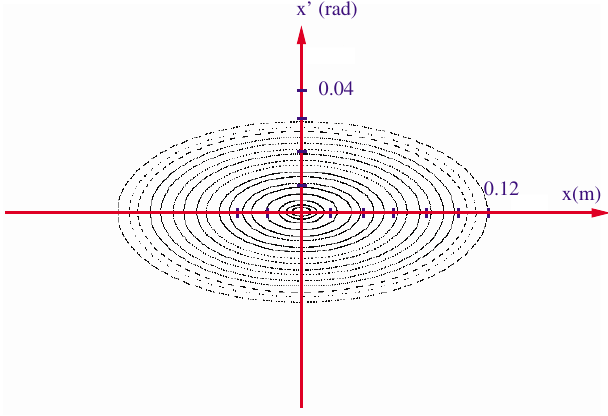
FIG. 18. (Color) Results from transverse particle tracking at the central 15 GeV muon energy. This is a result obtained by the COSY INFINITY code.